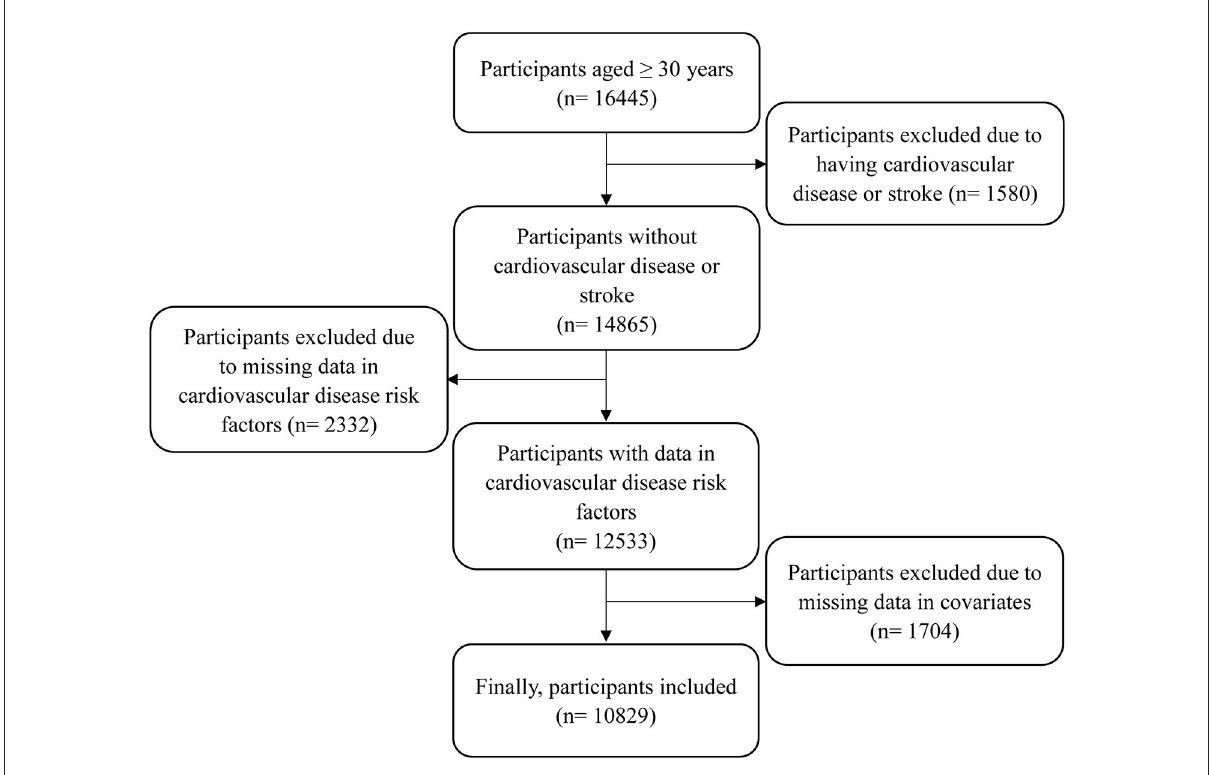
FIGURE1 The flow chart of participants